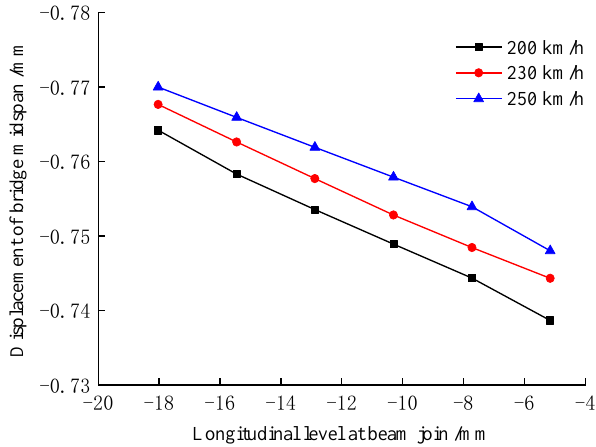
Figure 23. Displacement of bridge midspan.